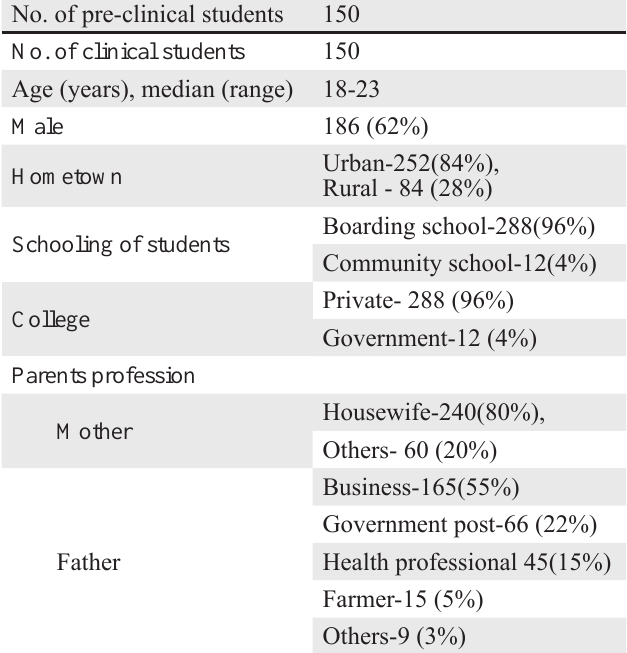
Table 1 : Characteristics of students included in study (N=300)